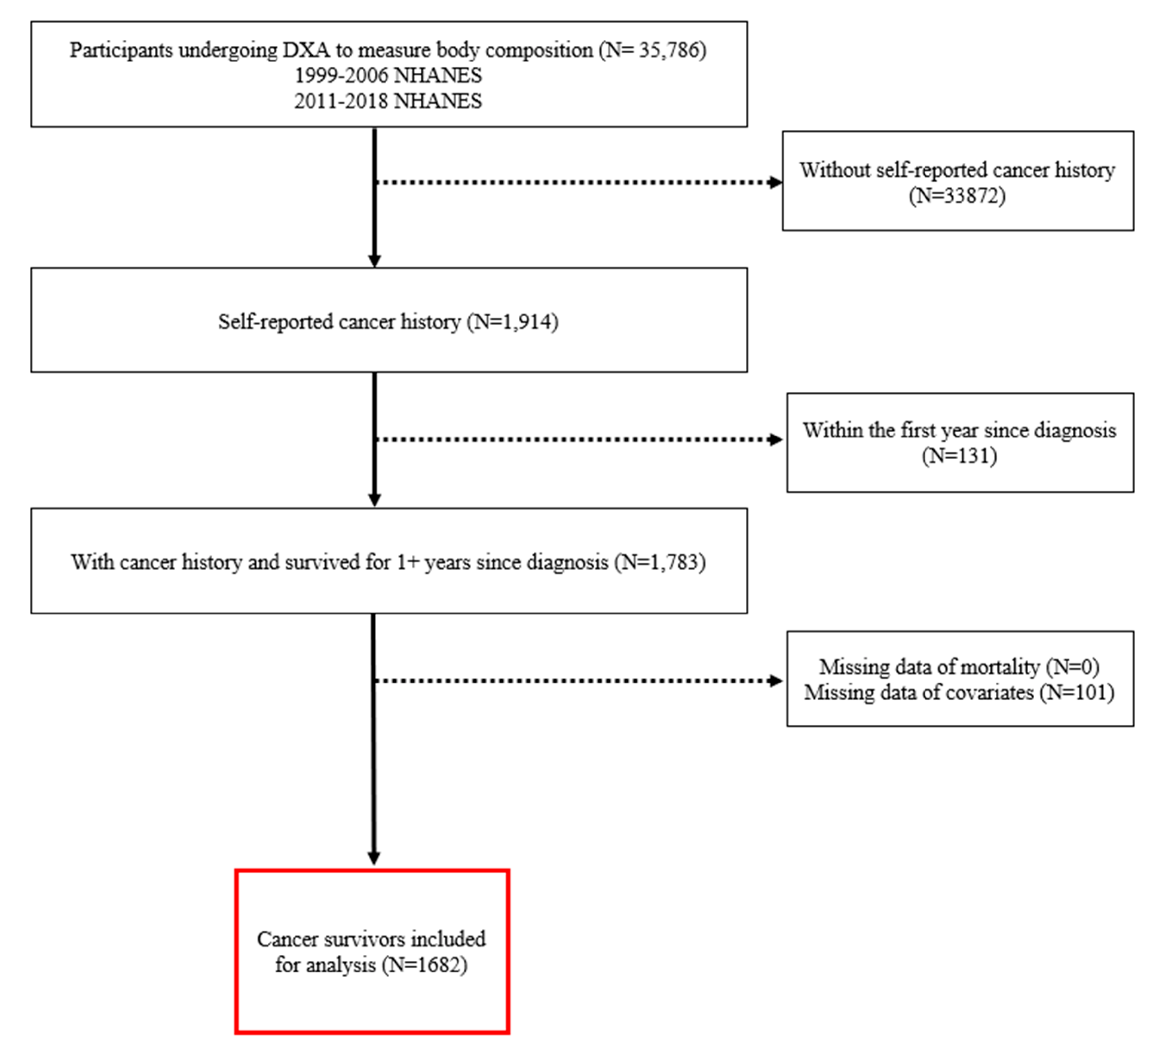
Figure 1. Participants selection diagram.